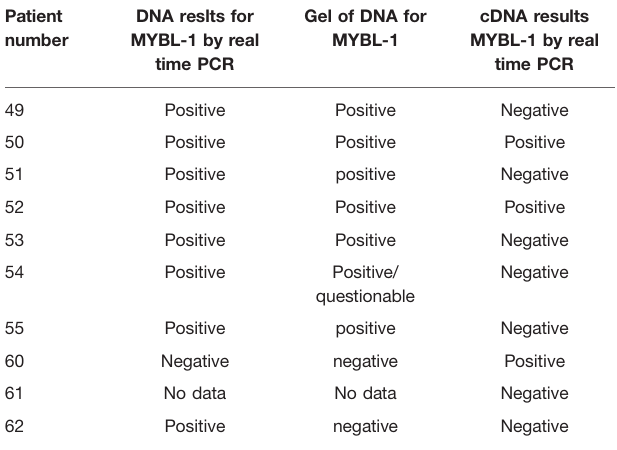
TABLE 4 | Results of MYBL-1 analysis in DNA and cDNA of same samples. Patient